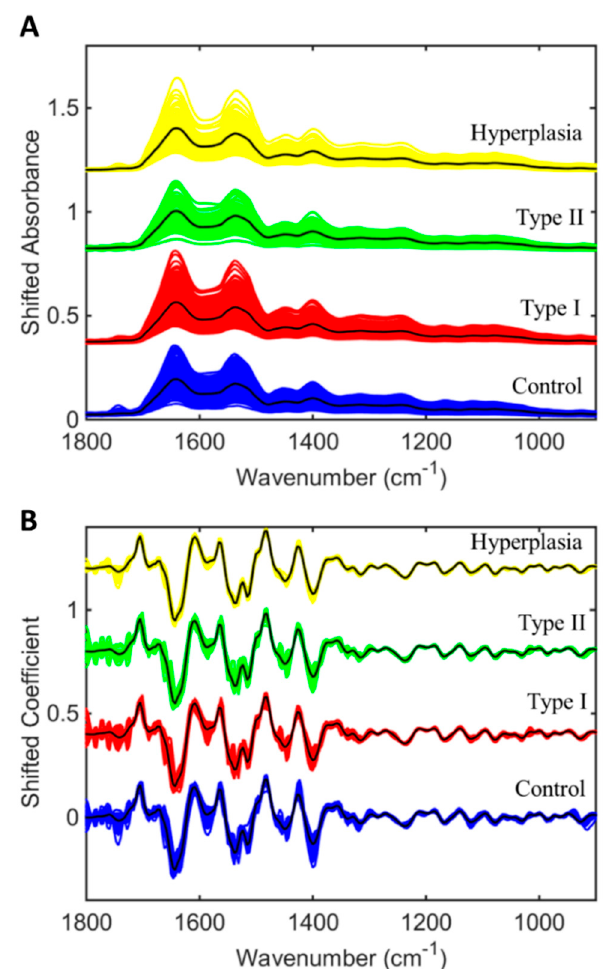
Figure 1. Infrared spectral data for the healthy controls ( n = 242), Type I cancers ( n = 258), Type II cancers ( n = 64) and atypical endometrial hyperplasia ( n = 68) at the fingerprint region (1800–900 cm − 1 ). ( A ) Raw infrared spectra for the different classes. ( B ) Pre-processed spectra after 2nd Savitzky–Golay (SG) derivative (window of 5 points, 2nd-order polynomial fitting) and vector normalization. Coloured lines denote all spectra, while black line shows the average spectrum.